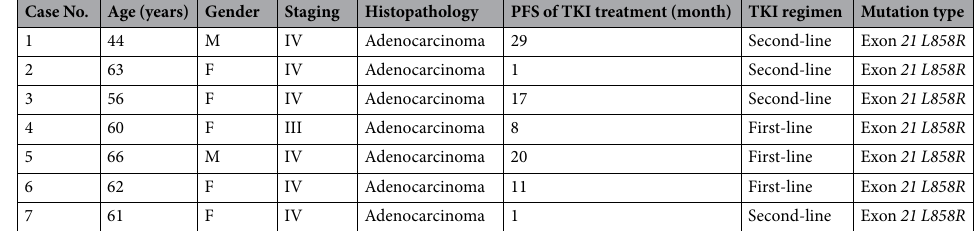
Table 1. Demographic and clinical characteristics of the study